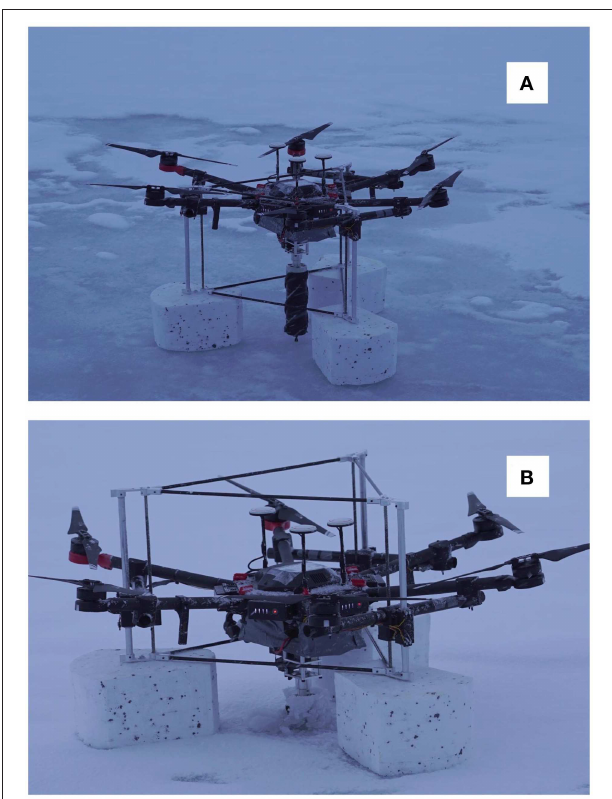
FIGURE 11 | (A) IceDrone landed on thin sea ice and (B) drilling into sea